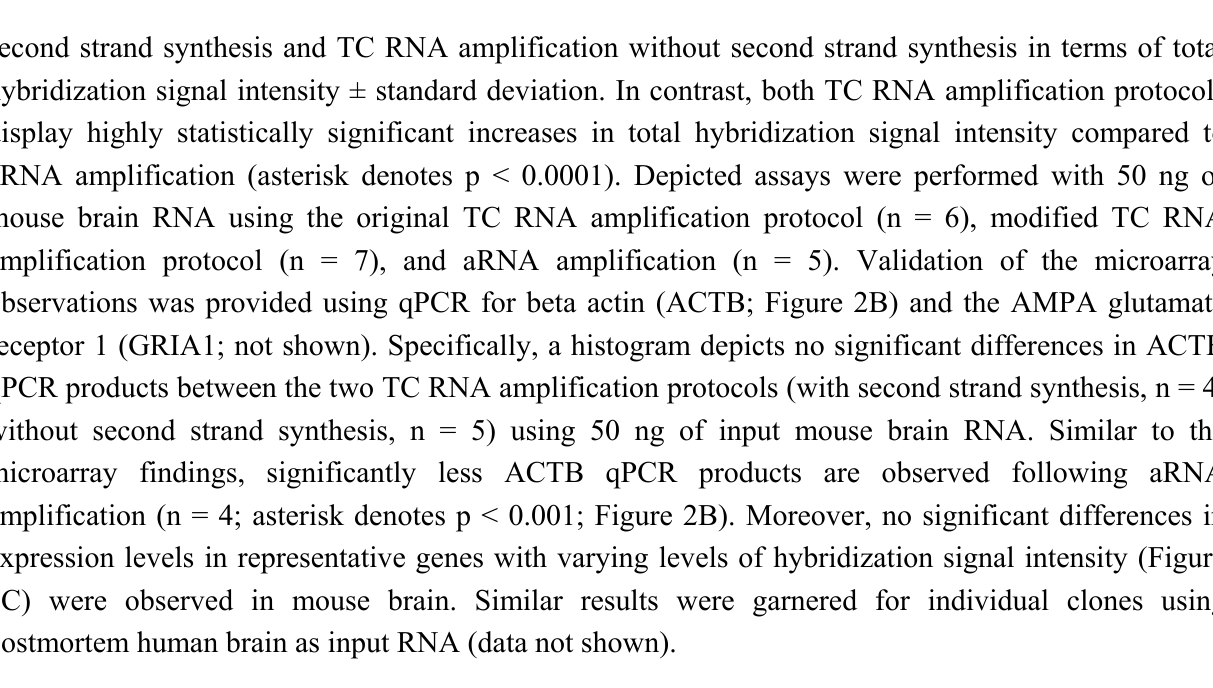
Figure 2. Comparison of the TC RNA amplification protocols and aRNA amplification using 50 ng of mouse brain RNA on specific gene expression levels. Key: APP, amyloid- beta precursor protein; CREB, cAMP response element binding protein; SOD1, superoxide dismutase; TUBB, beta